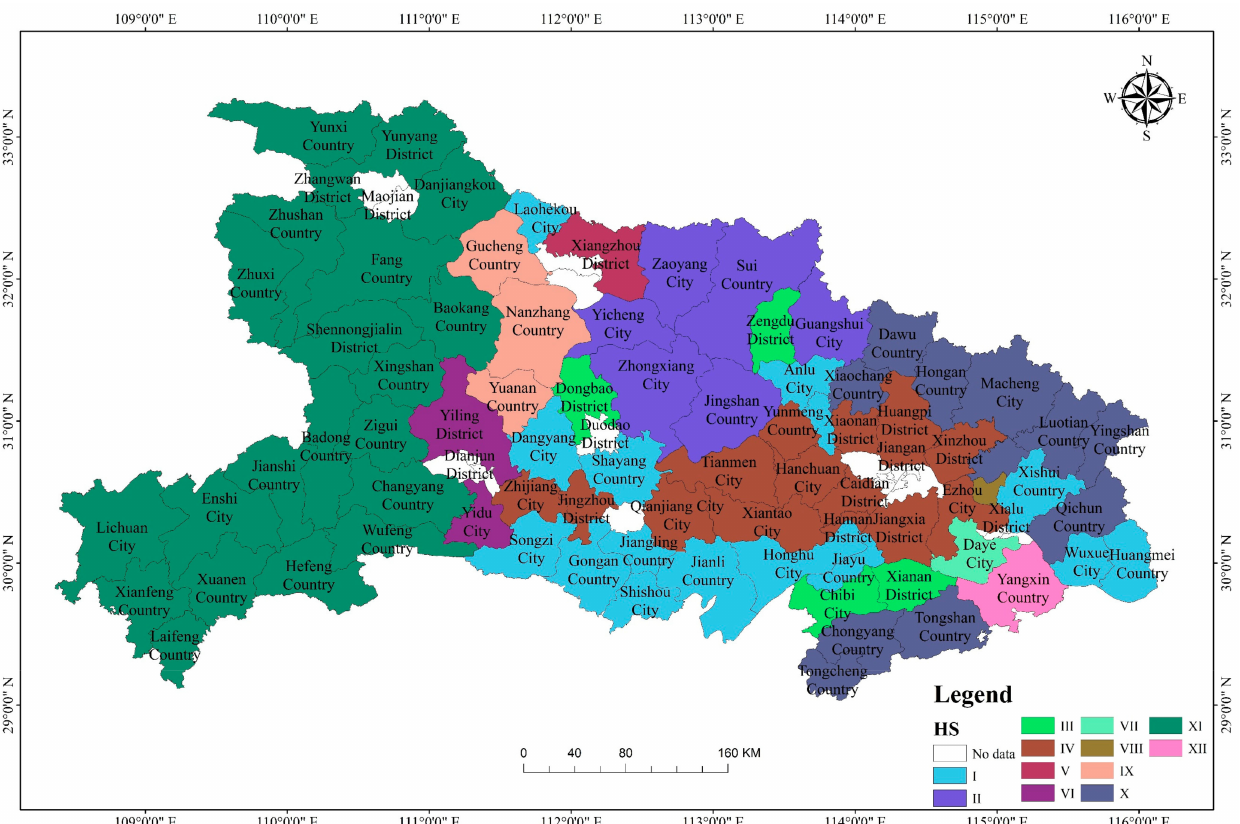
Figure 7. Map of land consolidation zoning scheme in Hubei province